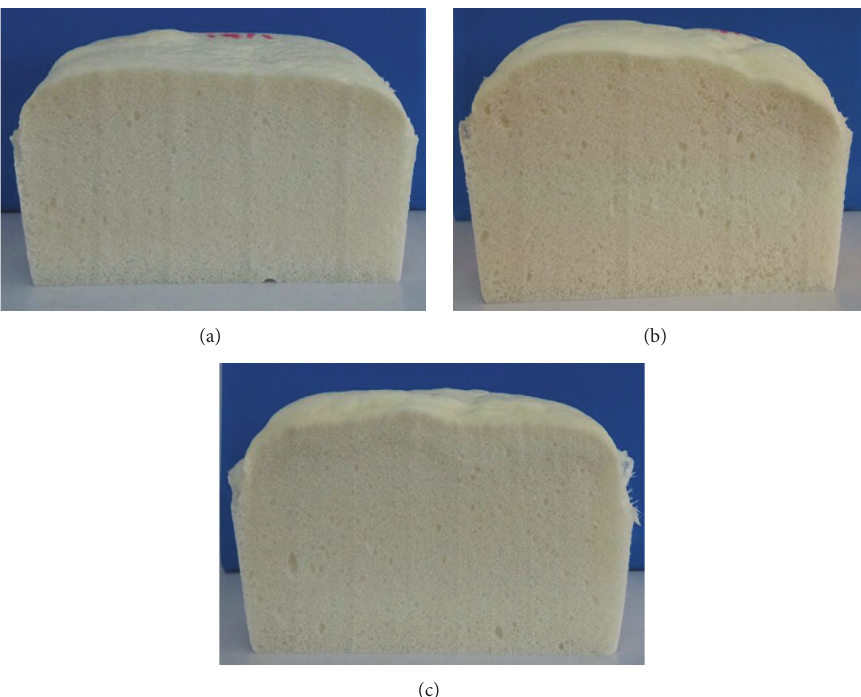
Figure 3: PU bionanocomposite foams prepared from 10% Pioneer E-135 with incorporation of (a) 3 wt% OMMT, (b) 5 wt% OMMT, and (c) 7 wt%